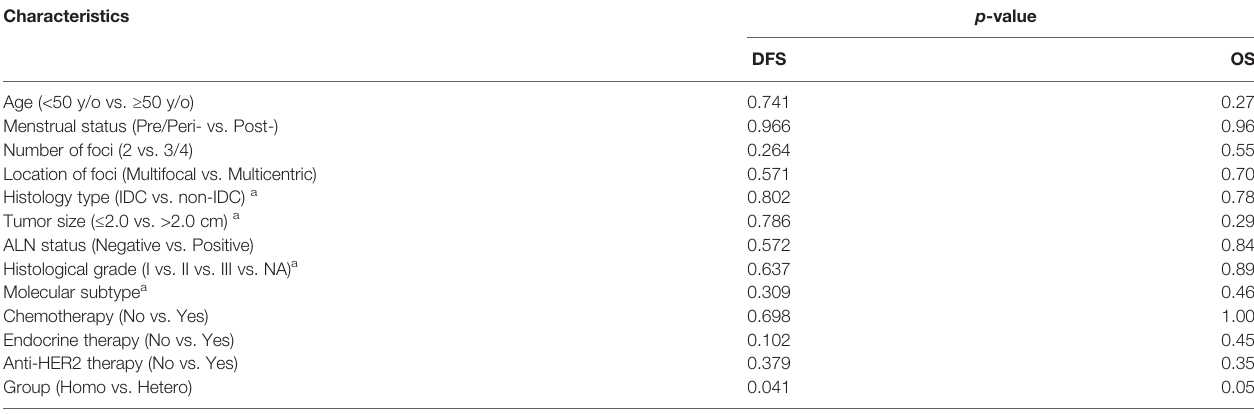
TABLE 5 | Univariate analysis of prognostic factors affecting DFS and OS among 330 patients with at least two invasive tumor foci. Characteristics